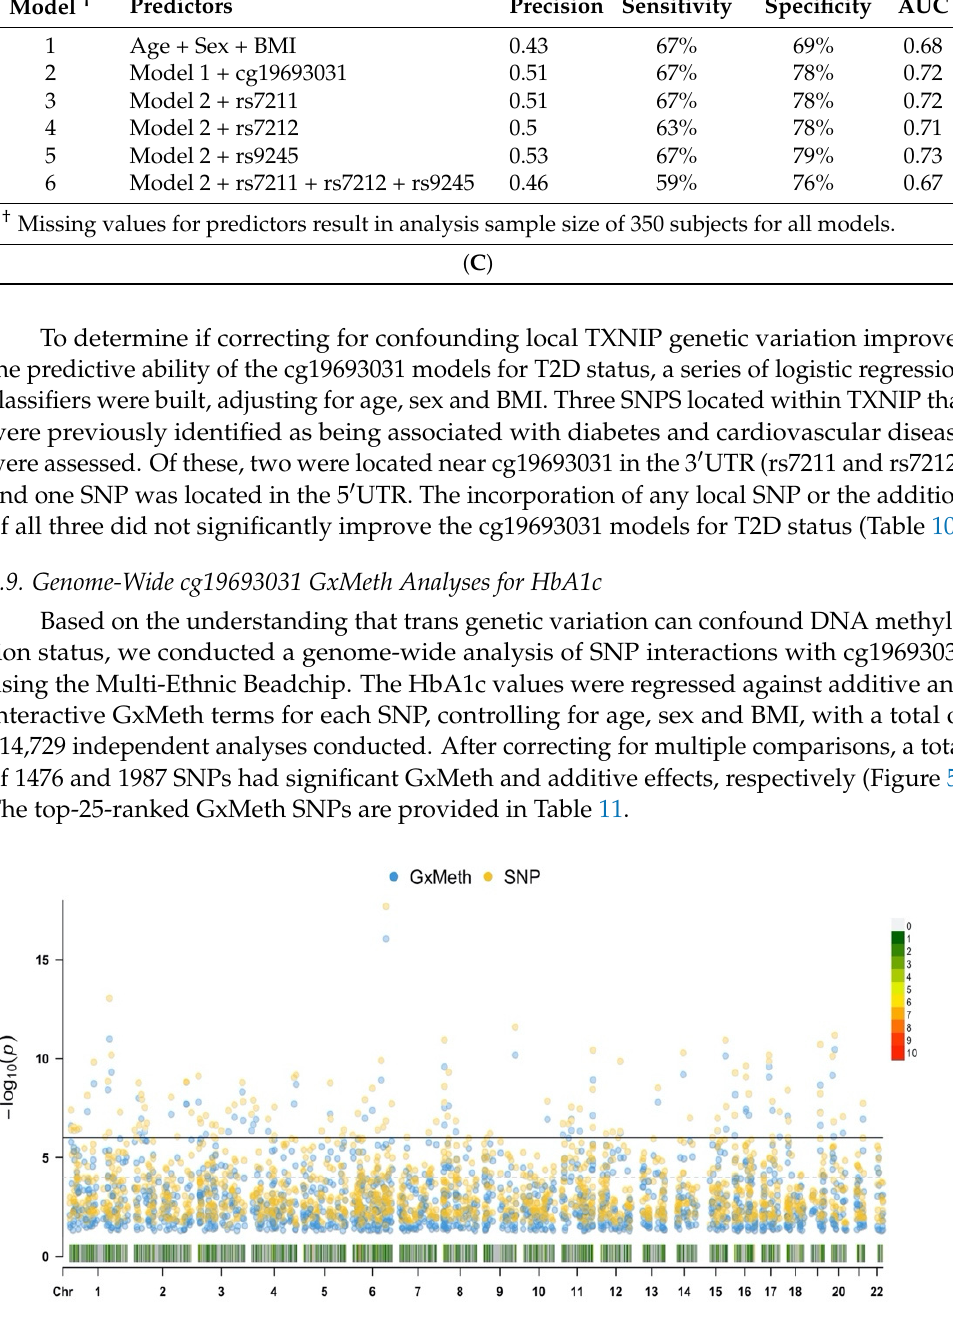
Figure 5. Manhattan plot illustrating the association of GxMeth and SNP terms with HbA1c. Re- sults were adjusted for age, sex and BMI, and corrected for multiple comparisons. Associations at p < 1.33 × 10 − 7 are above the horizontal black line. The chromosome density, number of significant SNPs residing within a 1 Mb window, is located at the bottom of the plot and the color-coded legend is to the right. Table 11. Top 25 ranked SNPs with GxMeth effects after Bonferroni correction.